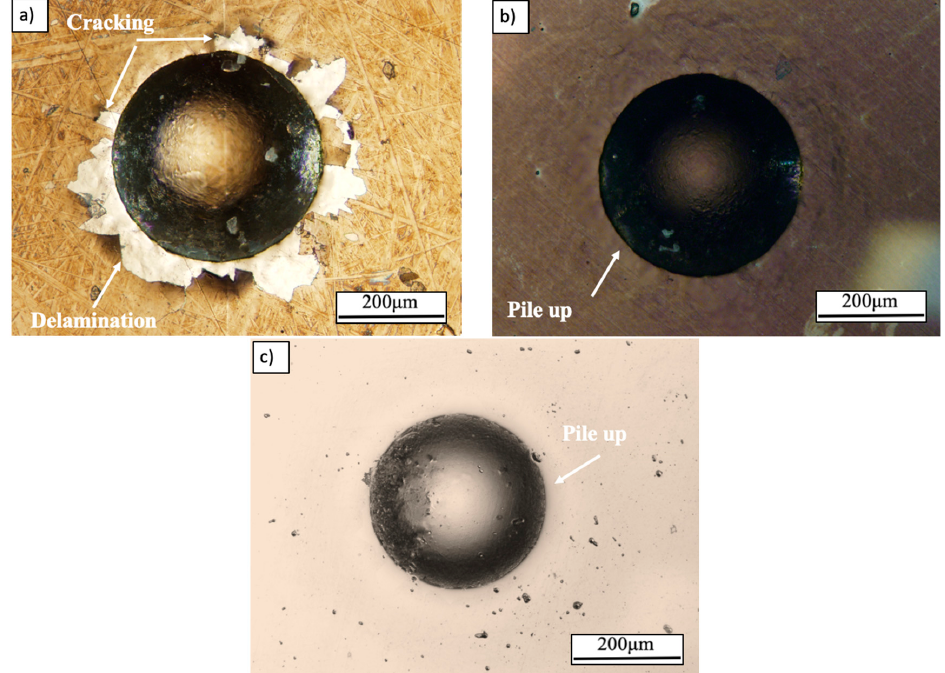
Figure 6. Single particle 90-degree impact a ) as-sputtered b ) 650 ° C nanolaminate c ) superelastic NiTi coatings.